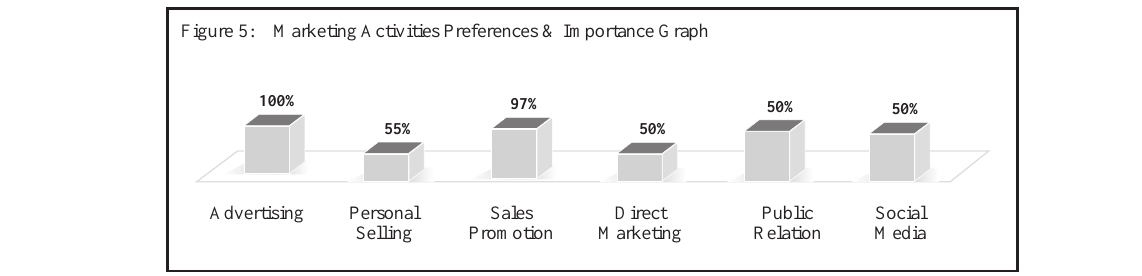
Figure 5: Marketing Activities Preferences & Importance